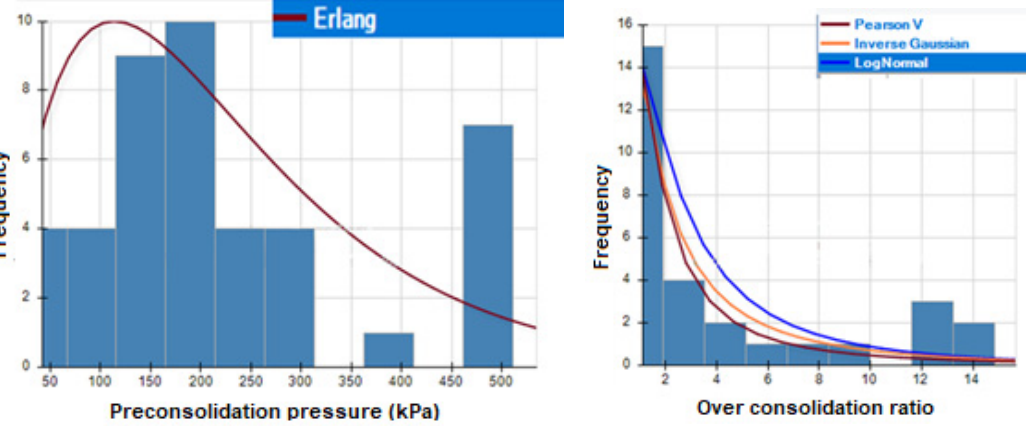
Figure 10. Adequate theoretical functions for data distribution of preconsolidation pressure and overconsolidation ratio.